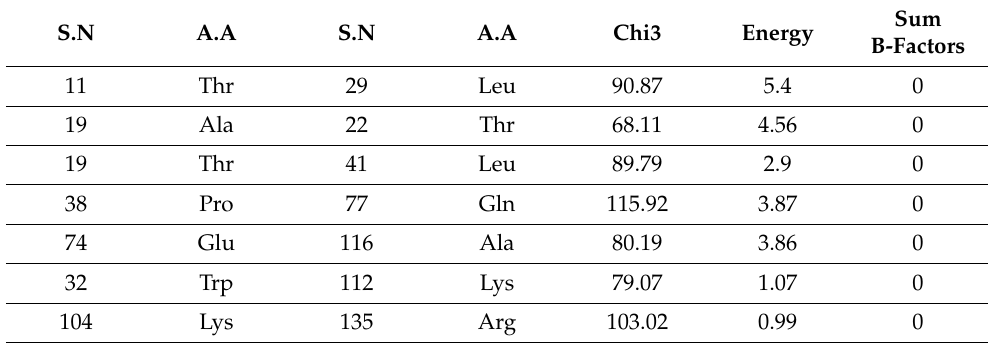
Table 4. Disulfide engineering of the designed vaccine. Sequence number (S.N), amino acid (A.A) Chi3, Energy and Sum B- factors of mutated amino residues.